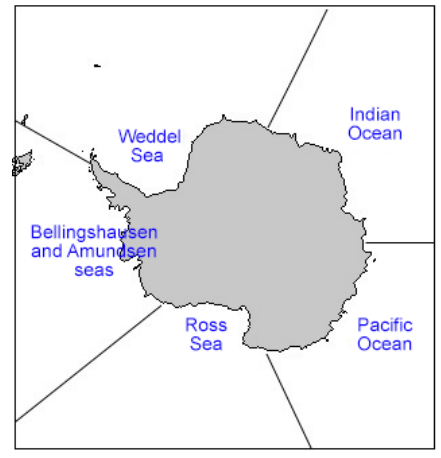
Figure 3. Southern Hemisphere regions as defined by Parkinson and Cavalieri (2012).